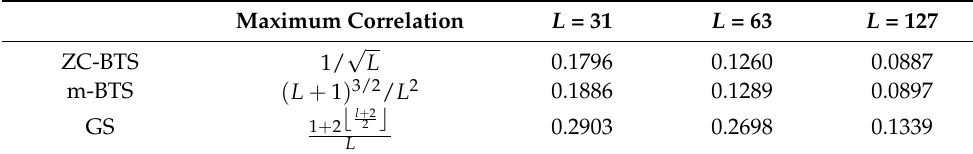
Table 1. Maximum correlation values of the ZC-BTS, m-BTS, and GS.